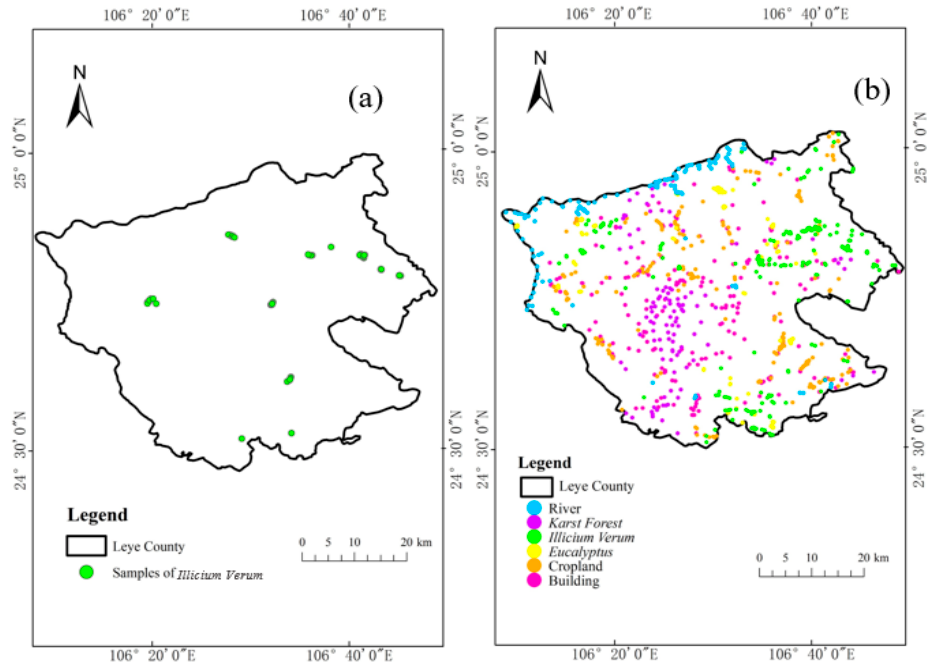
Figure 2. ( a ) Distribution map of Illicium verum samples from field surveys ( b ) Distribution map of six types of land cover samples.